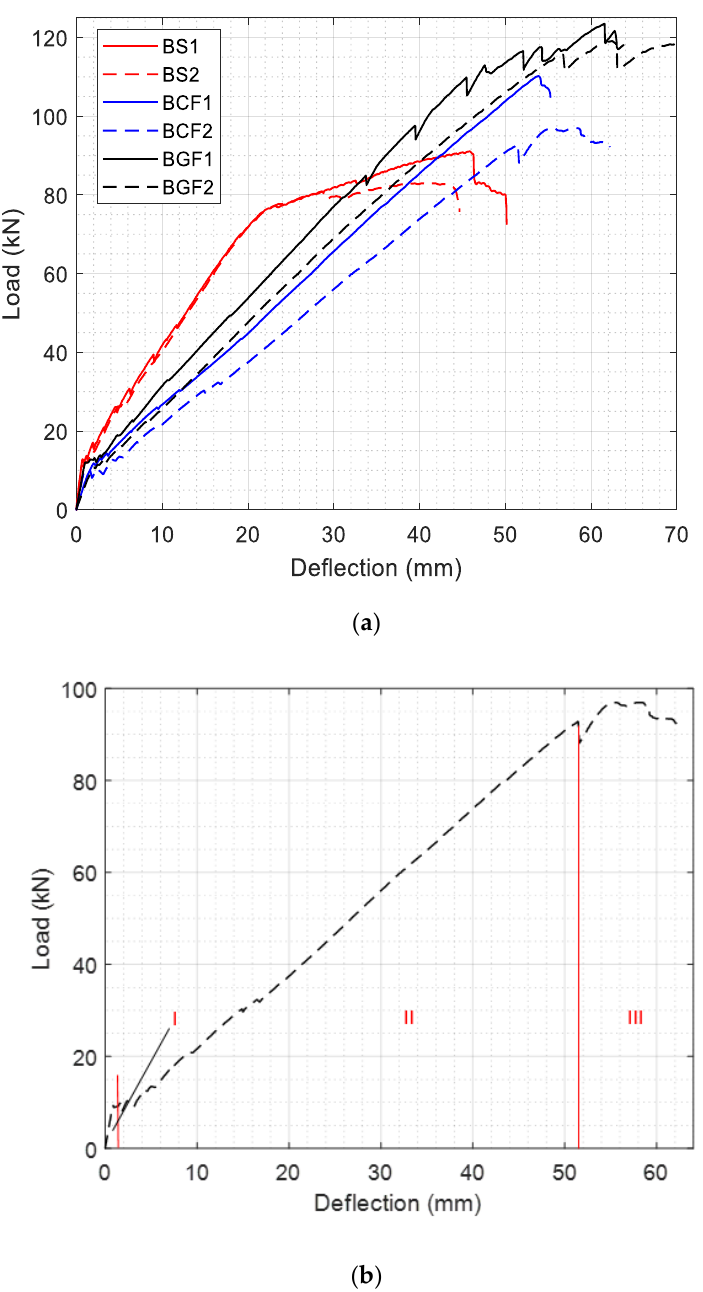
Figure 7. ( a ) Load–deflection curves for the tested beams. ( b ) Example of three segments of load–deflection curves using